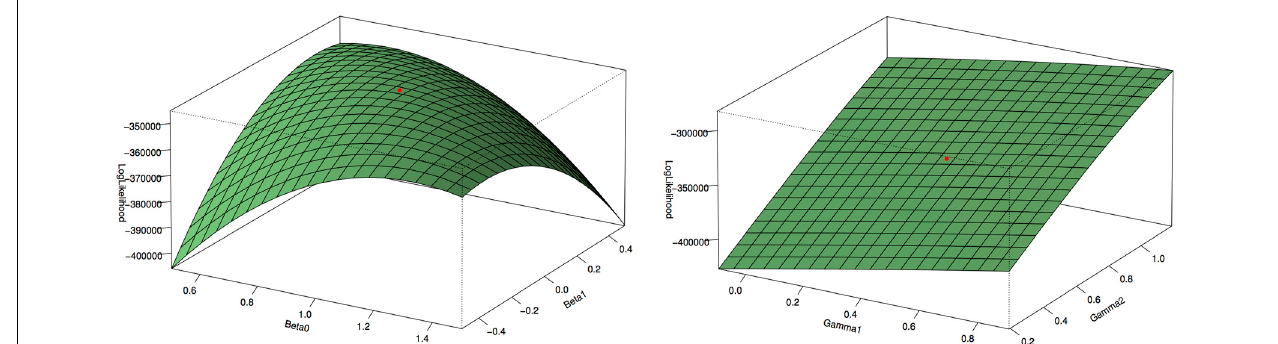
FIGURE 2 | Log Likelihood surface specified by Lin and Zeng. The plot on the left is the log Likelihood specified by Lin and Zeng for varying values of β 0 and β 1 with all other parameters fixed at their true values and for data generated under the null hypothesis with γ 1 = log (1 . 5) and the disease rate equal 5%. The plot on the right is the log Likelihood specified by Lin and Zeng for varying values of γ 1 and γ 2 with all other parameters fixed at their true